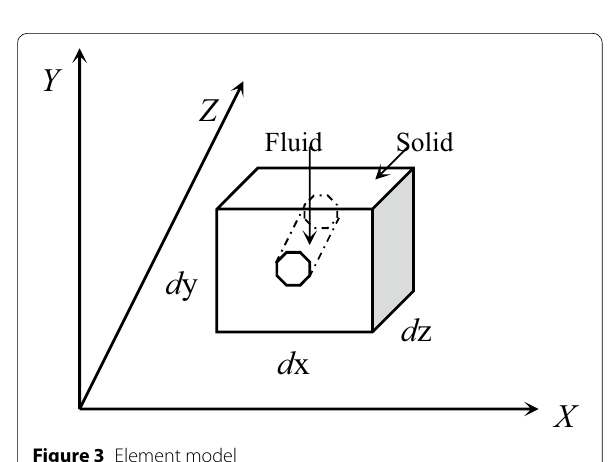
Figure 3 Element